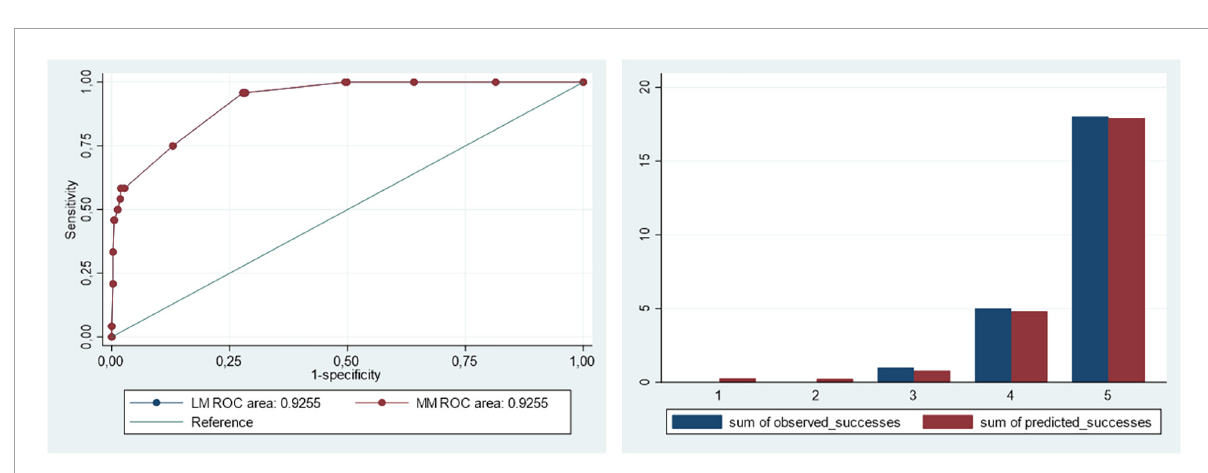
FIGURE1 Discrimination and calibration of the logistic and multilevel risk adjustment models for in-hospital